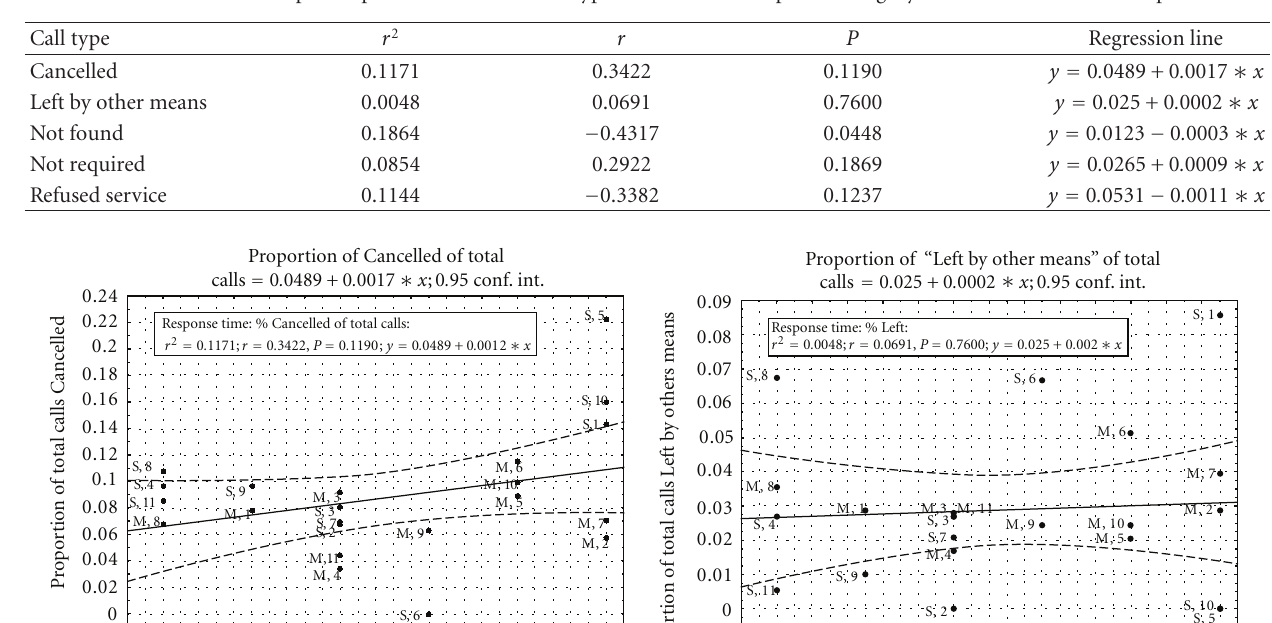
Table 3: The relationship of response time and the call types in the Non-transported category controlled for station and parish.